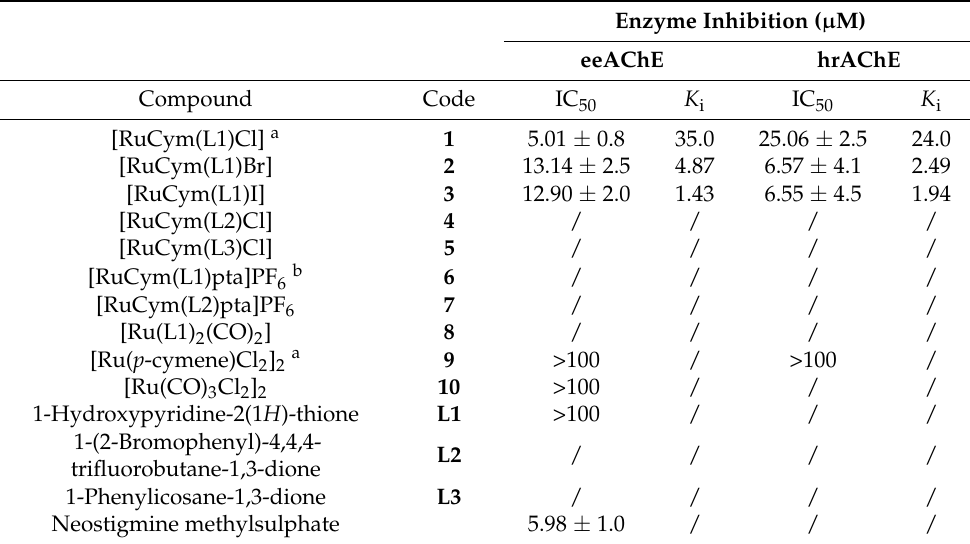
Table 1. Inhibition of electric eel (eeAChE) and human recombinant acetylcholinesterase (hrAChE) by the ruthenium compounds 1 – 10 and the free ligands L1 – L3 .